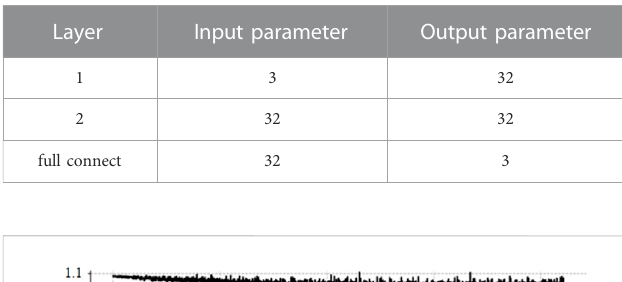
TABLE 4 LSTM network parameters.